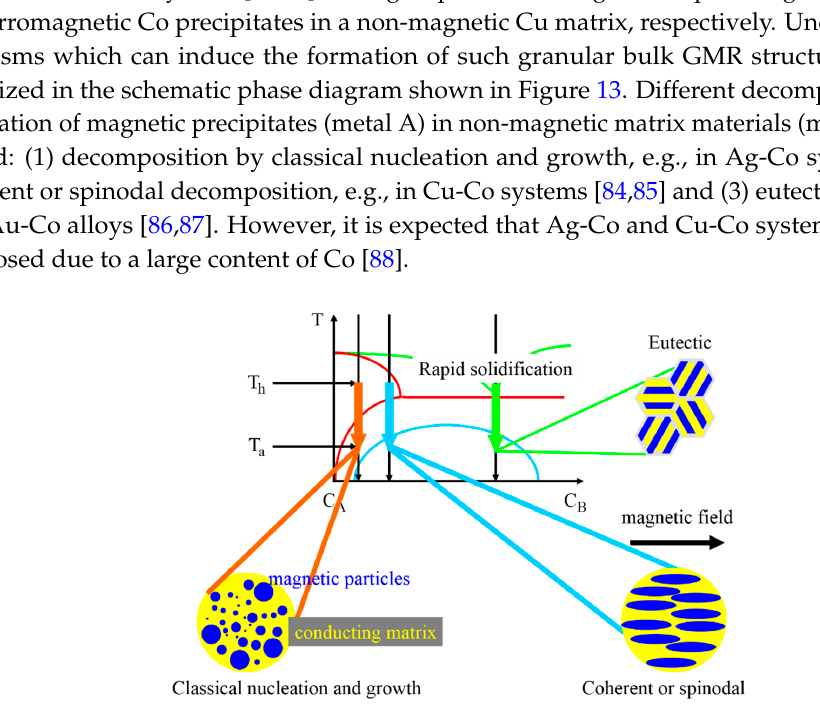
Figure 14. Schematic illustration of the granular GMR effect in dependence of the particle size. The dependence of the granular GMR on the ferromagnetic volume fraction is comparable to the particle size dependency: At low ferromagnetic volume fractions, the particles are small and few in number, therefore only a small granular GMR is measurable. With increasing ferromagnetic volume fraction, the granular GMR increases until it reaches the optimum value at a ferromagnetic volume fraction between 15% and 30%, depending on the used material system. Thereafter, it decreases with an increasing ferromagnetic volume fraction as the particles become larger and more densely packed